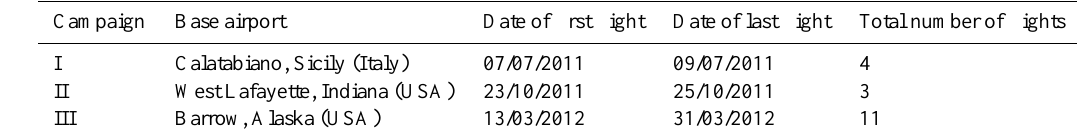
Table 1. List of conducted measurement campaigns to date, with corresponding time period and number of flights.